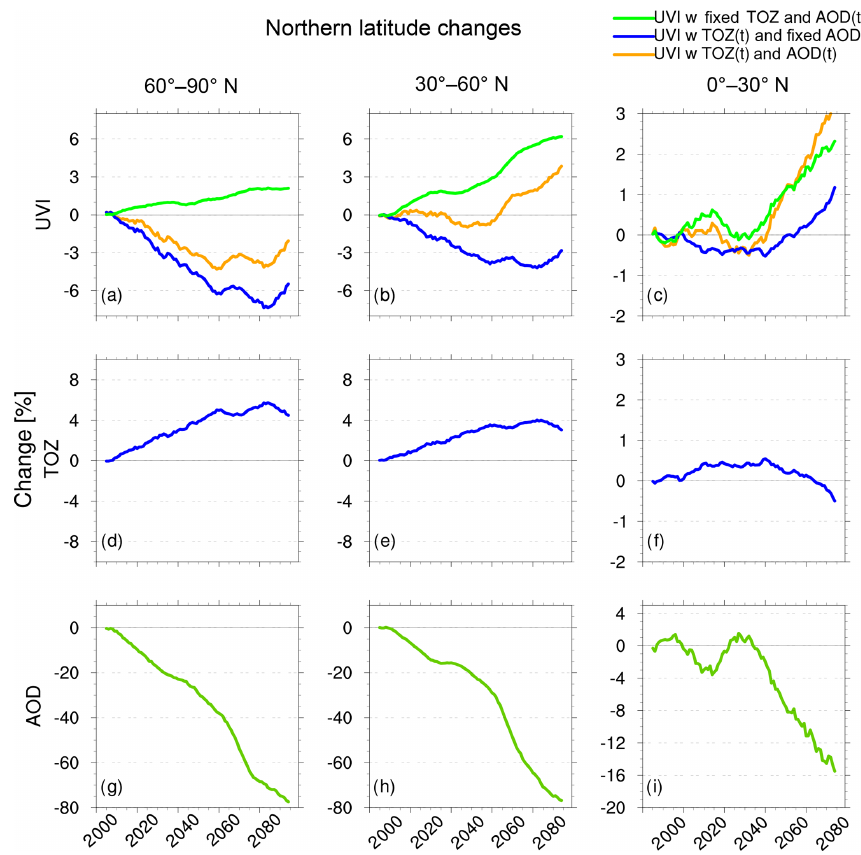
Figure 8. UVI, TOZ and AOD percent change from 2000 to 2010 values in the northern high, middle and low latitudes for the EXP3 experiment. UVI modelled with transient TOZ and AOD fixed at present-day climatological values are in blue. UVI modelled with TOZ fixed at present-day climatological values and AOD variable through the 21st century are in green. UVI modelled with transient TOZ and AOD are in orange. TOZ and AOD are respectively in blue and green. Table 6. Percent changes in UVI, TOZ and AOD between 2100 and 2000 for the EXP3A, EXP3FTOZ and EXP3FAOD experiments. Region UVI TOZ AOD Comments EXP3A EXP3FTOZ